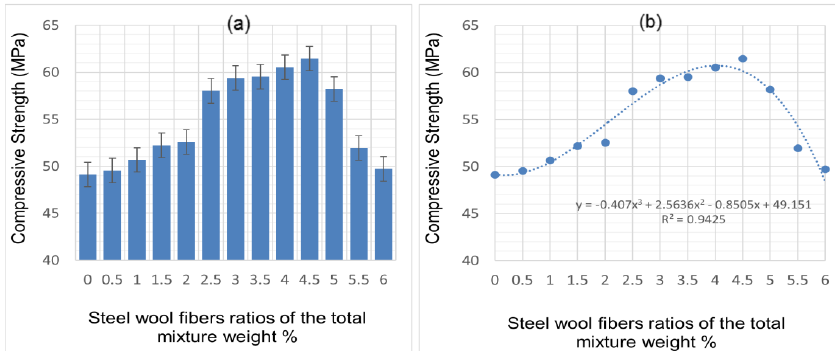
Figure 6. Compressive strength of cement mortar at various CSWF ratios: ( a ) compressive strength values corresponding to the CSWF ratios, ( b ) correlation between compressive strength and CSWF addition.